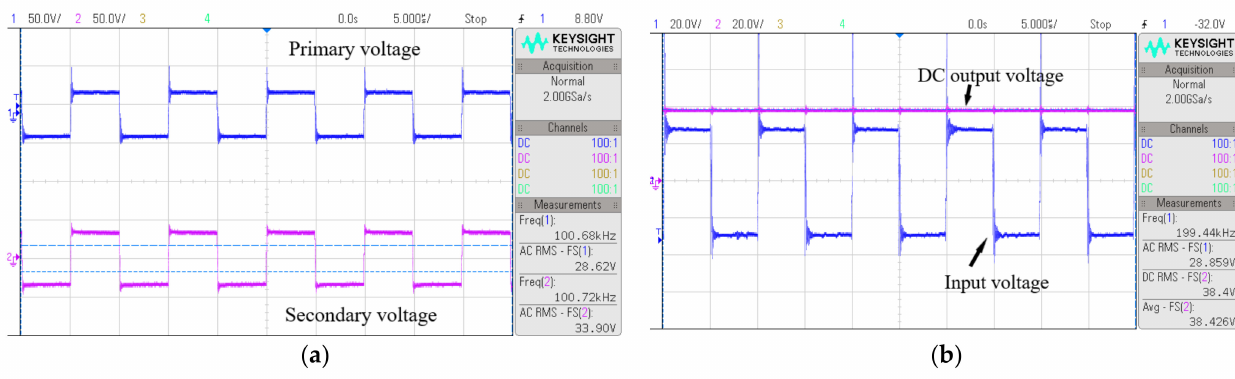
Figure 20. Waveform responses of the I-SiC-HFT: ( a ) Sinusoidal excitation; ( b ) Square-wave